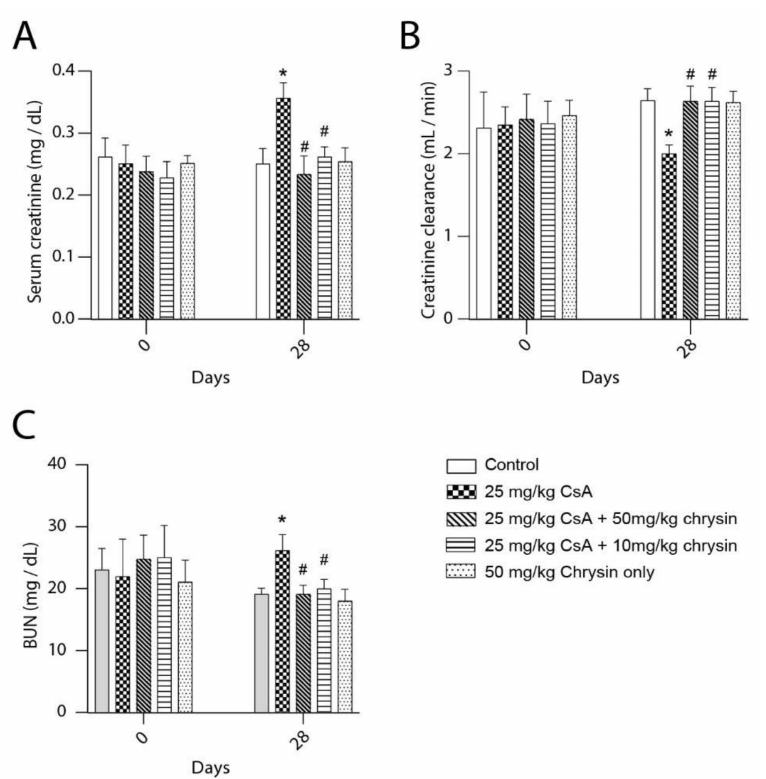
Figure 1. Effect of chrysin on cyclosporine A (CsA)-induced renal dysfunction. Male Sprague Dawley rats were treated with 25 mg/kg cyclosporine A (CsA) with or without 10 mg/kg or 50 mg/kg chrysin. ( A ) Serum creatinine, ( B ) creatinine clearance and ( C ) BUN levels measured on days 0 and 28 are shown. Data is represented as means ± SD with at least 5 animals per treatment group. Statistical significance was determined by one-way ANOVA followed by Tukey’s test for multiple comparisons.